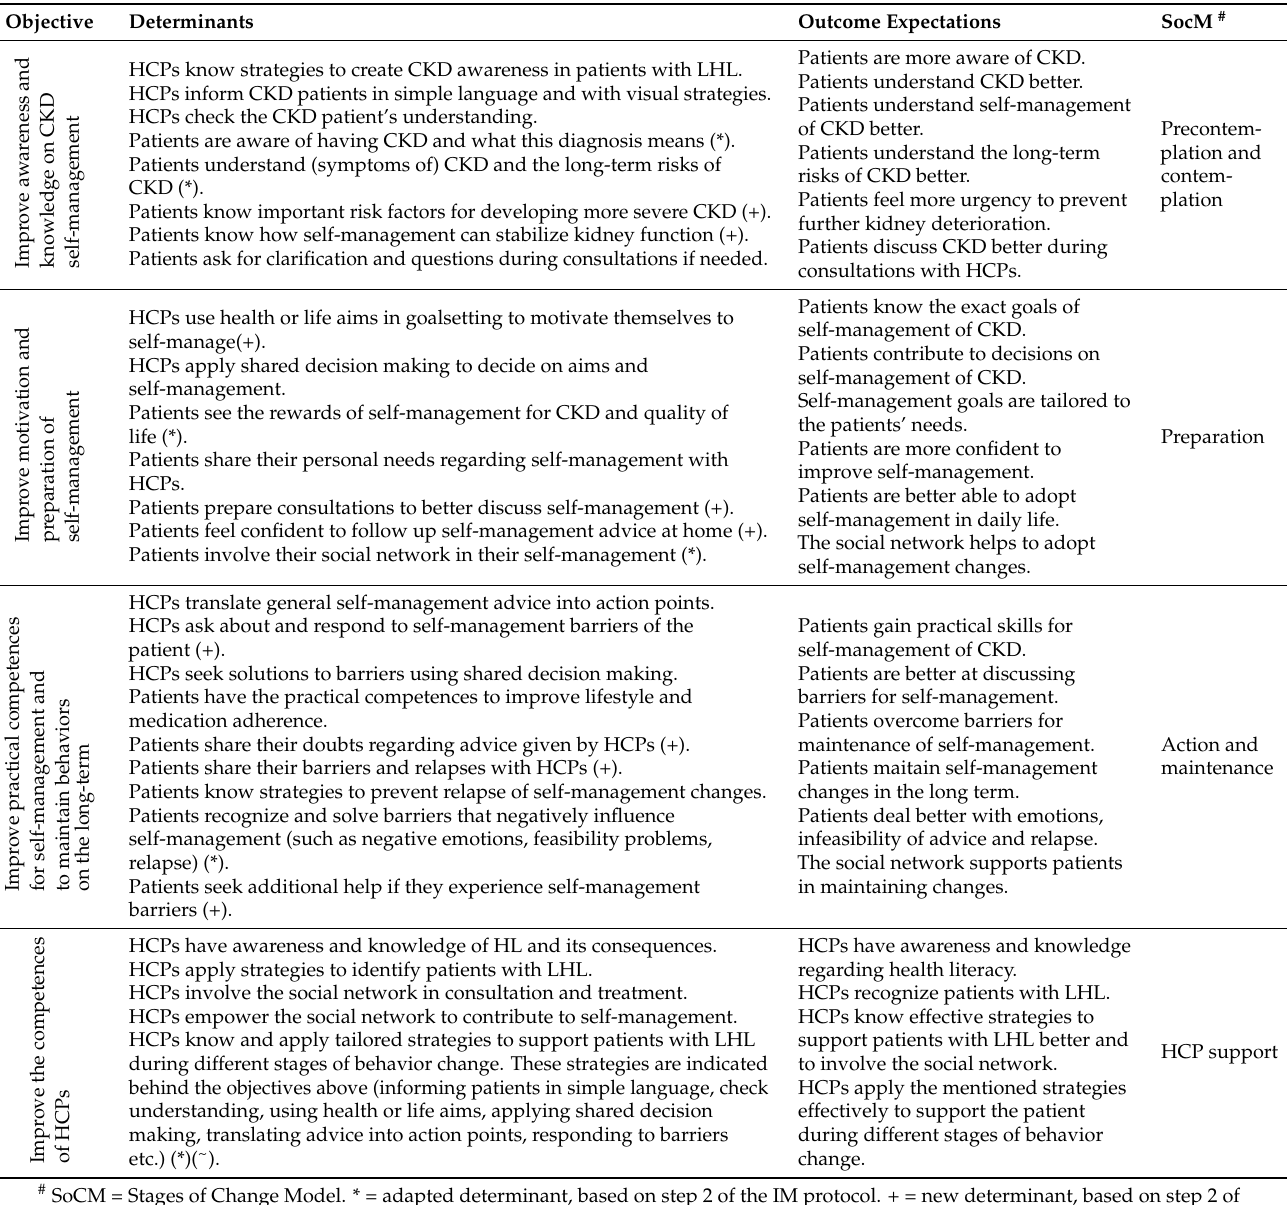
Table 4. Final logic model of change with the four components of our intervention, and final objectives, determinants and outcome